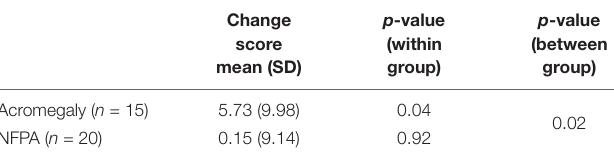
TABLE 5 | Difference in mean CES-D scores (pre-post) comparison between acromegaly ( n = 15) and NFPA ( n = 20) patients.